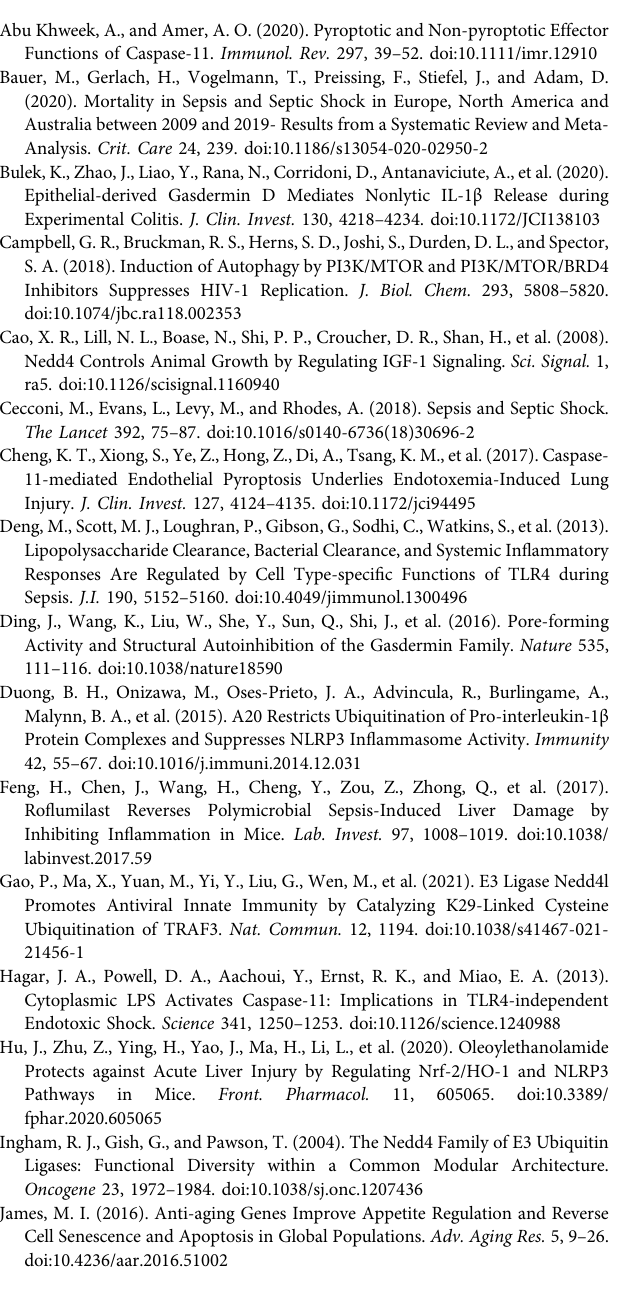
Supplementary Figure 1 | LPS activated non-canonical pyroptosis in RAW264.7 cells. (A) Westernblottingshowingtheproteinlevelsofcaspase-11andGSDMD-NT in cell lysates. (B) Percentage of LDH release in the culture supernatants. (C) LPS in cytoplasm of RAW264.7 cells. After transfected with FITC-LPS for 16 h, the cells